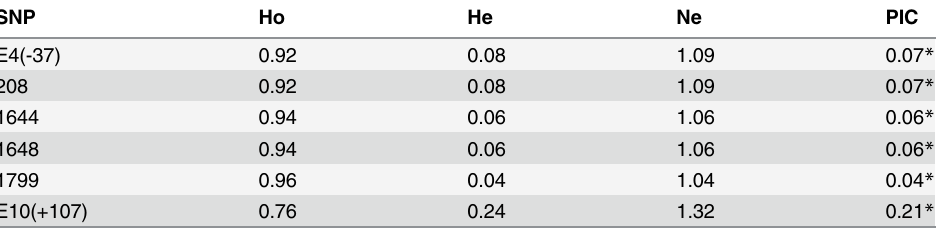
PIC > 0.5 stands for high polymorphism; 0.25 < PIC < 0.5 as moderate polymorphism; PIC < 0.25 stands for low polymorphism. * Low polymorphism (PIC < 0.25).